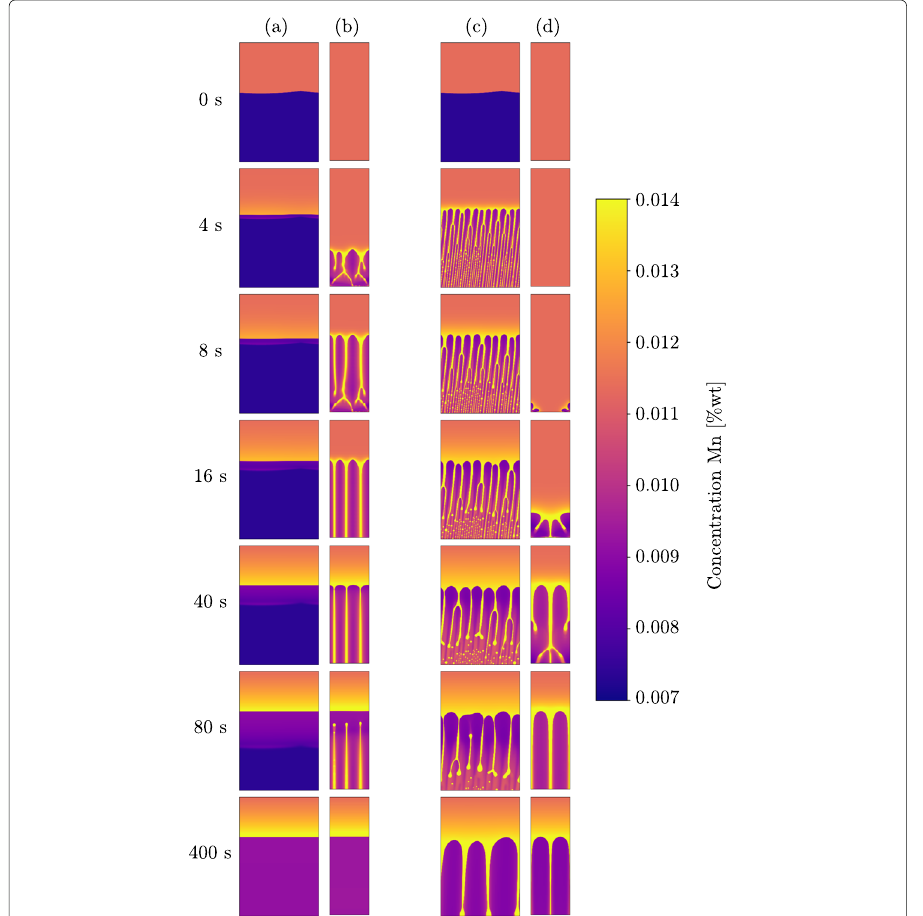
Fig. 15 Temporal evolution (Mn-concentration) for simulations with (a),(c): initial planar front and constant G and V and (b), (d) 1D temperature field calculation with nucleation of a small nucleus. (a) G = 10 Kcm − 1 , V pull = 6 μ ms − 1 , (b) (cid:7) G (cid:8) = 10.5 Kcm − 1 , V front = 6.5 μ ms − 1 , (c) G = 2 Kcm − 1 , V pull = 6 μ ms − 1 . (d) μ ms − (cid:7) G (cid:8) = 2.7 Kcm − 1 , V front = 5.8